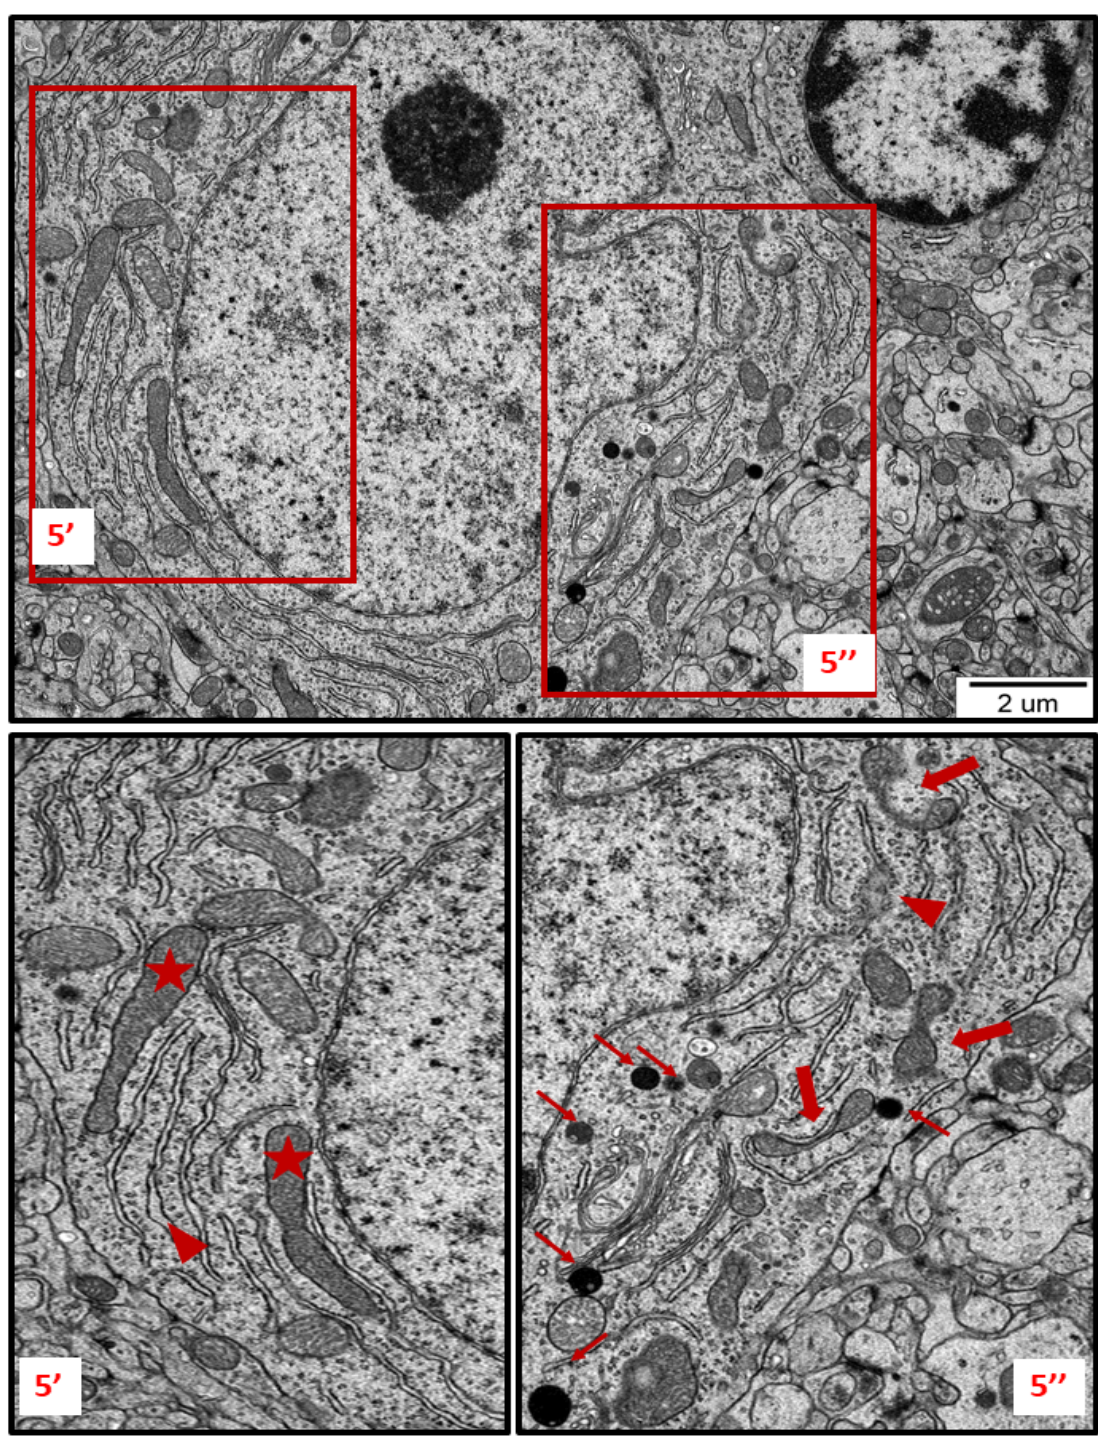
Figure 5. TEM micrograph showing ultrastructural changes in subcellular structures of neurons in brain sections obtained from AgNP-treated rats. Enlarged and swollen rough endoplasmic reticulum (RER) cisternae with blurred fragments (arrowheads) and detached ribosomes in the cytoplasm; elongated forms of mitochondria (asterisks); fragmentation of mitochondria (thick arrows); lysosomes (thin arrows). The insets (5 ′ , 5 ″ ) are magnified 2–3×. Images are representative for each of the 3 animals.